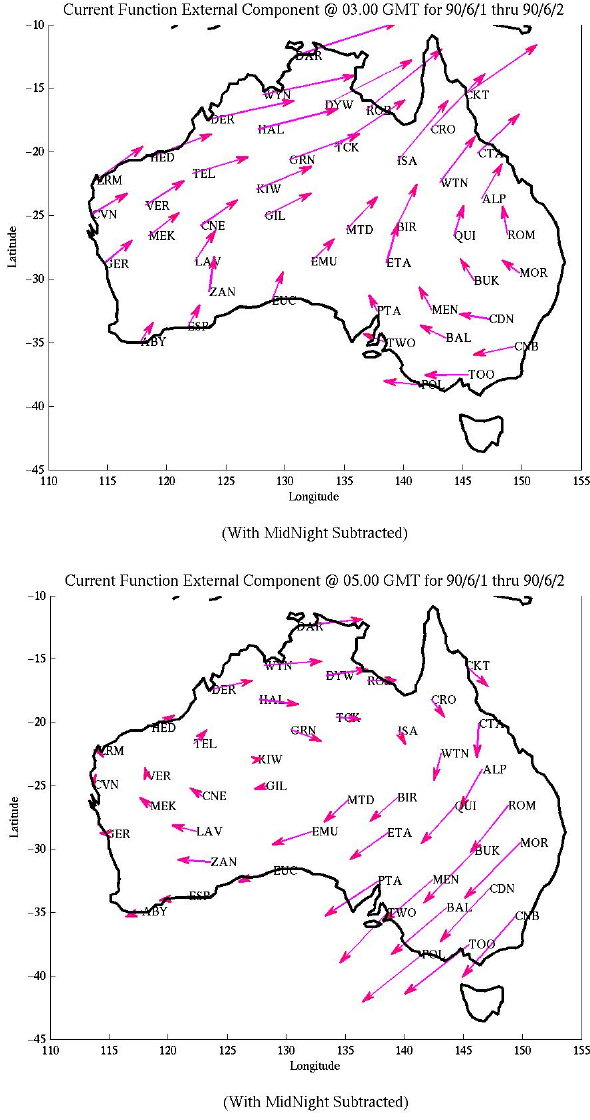
Fig. 2. Magnetic variations on 21 June 1990 at ( a ) Albany (ABY), ( b ) Cooktown (CKT), ( c ) Derby (DER) and ( d ) Toolangi (TOO). Hourly values of the northward ( X ) and eastward ( Y ) fields are plot- ted. The scales are in nanotesla.